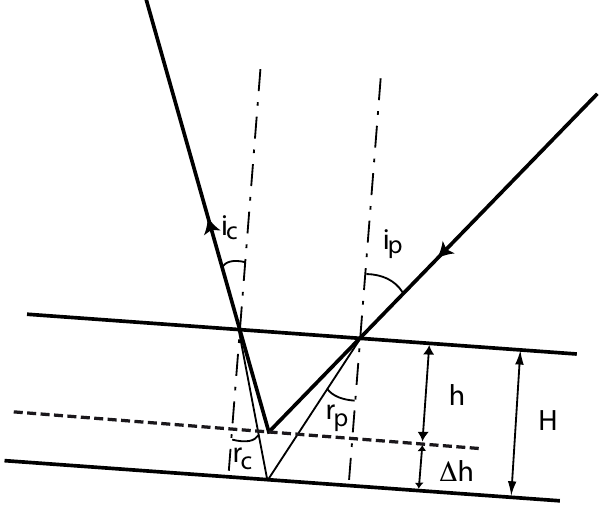
Fig. 3. Light refraction into a water